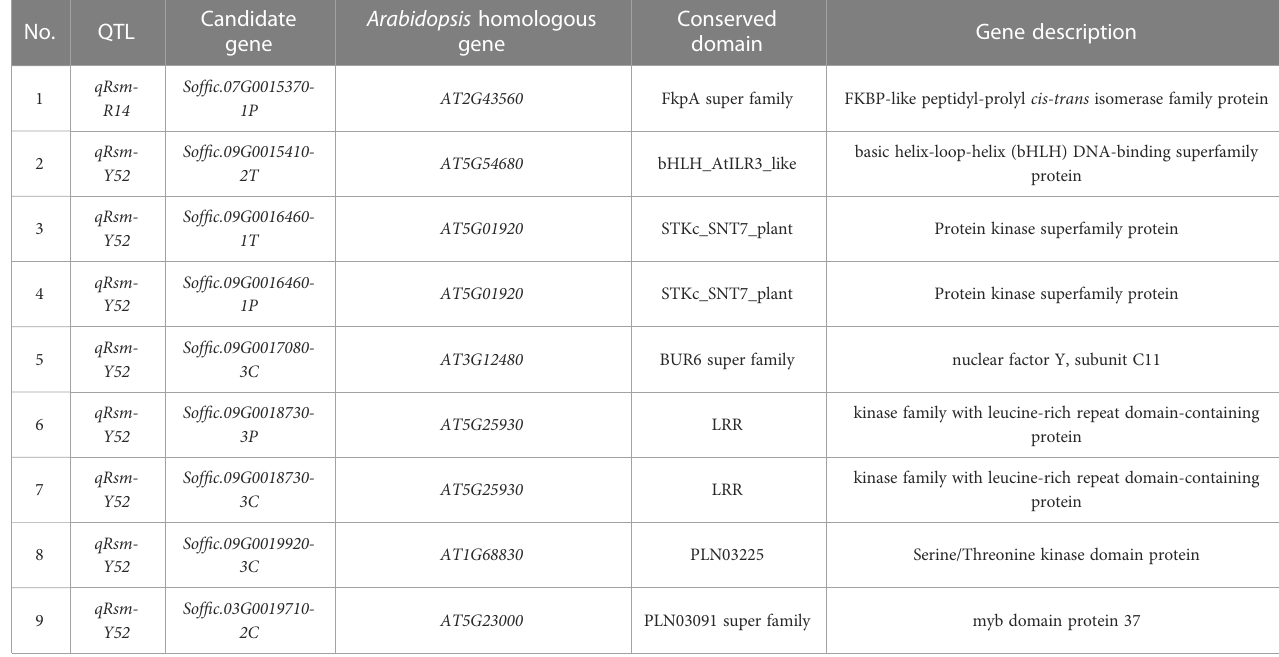
TABLE 4 Information for SMD resistance-related key genes. No. QTL